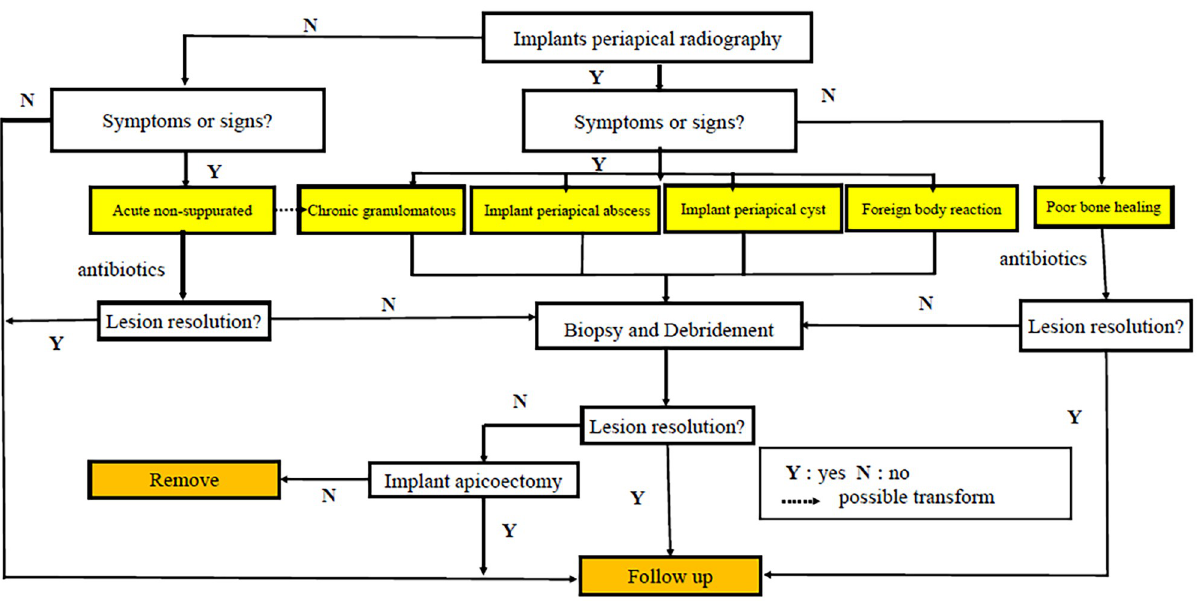
Fig 3. Treatment decision